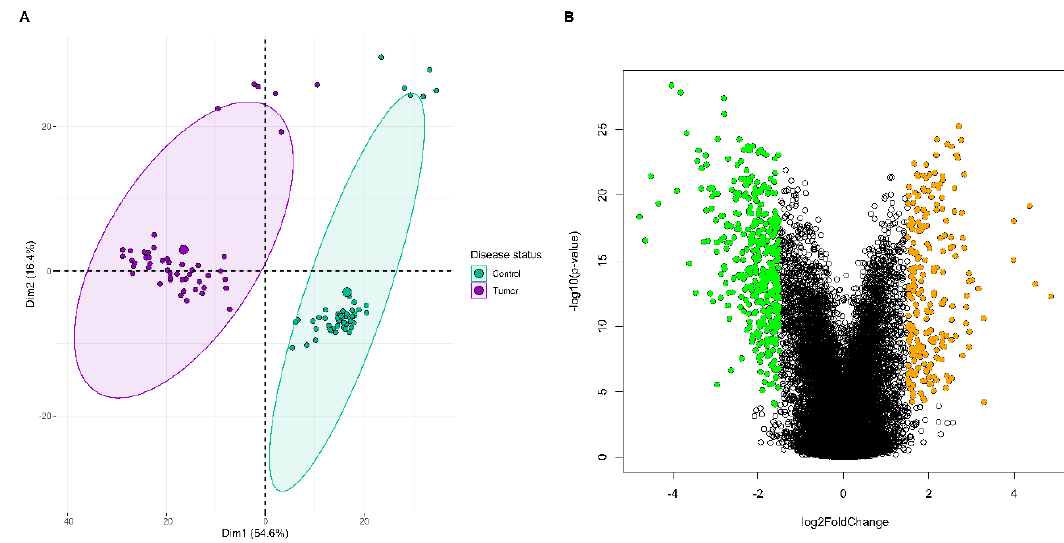
Figure 1. ( A ) Principal component analysis (PCA) plot showing the expression distribution of 603 meta-differentially expressed genes (meta-DEGs) between normal and tumor samples. Every point in the plot represents the relative expression value of all DEGs in each sample. The disease status is distinguished by the color of points, i.e., magenta for tumor and green for normal samples. It could be seen that both the normal and tumor samples are clustered independently and distinctly. The percentage of total variation that is accounted for by the 1st and 2nd principal components are shown on the x and y axes, respectively. ( B ) Volcano plot distribution highlighting 603 meta-DEGs between normal and tumor samples. The orange and green colored points denote the up (218) and downregulated (385) meta-DEGs. All the black colored points denotes non-significant genes. The x and y axes represent the log 2 FC and −log 10 𝑝 − 𝑣𝑎𝑙𝑢𝑒 , respectively.